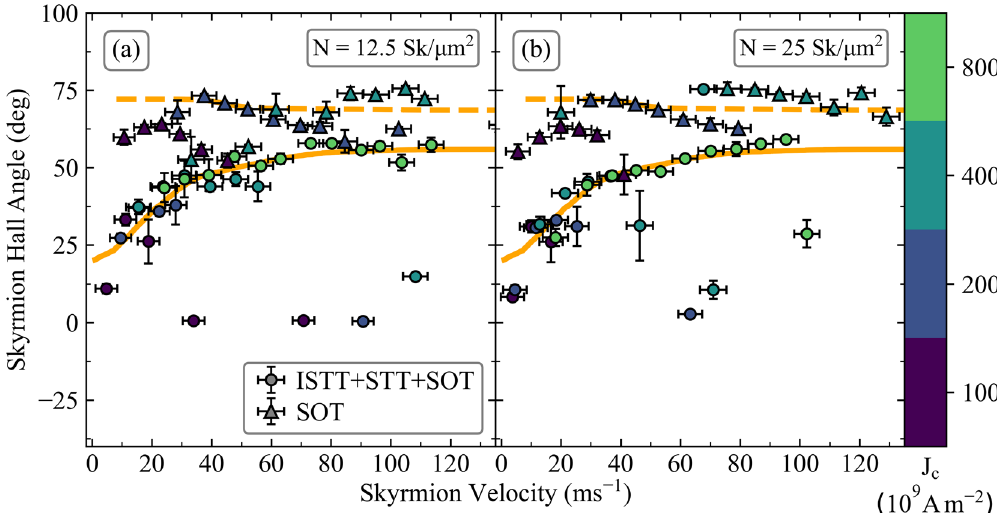
Figure 4. SkHA dependence on the skyrmion velocity with landscape disorder, for skyrmion collections with ( a ) N = 12.5 Sk/µm 2 and ( b ) N = 25 Sk/µm 2 . The solid disks and triangles show results for ISTT + STT + SOT, and SOT-only respectively, for a corresponding applied current density indicated by the colour bar. The magenta diamonds indicate the mean value obtained from experiments (average J C = 2 × 10 11 A/m 2 ). The solid and dashed lines are Savitzky–Golay-fit trend lines, for ISTT + STT + SOT, and SOT respectively, acting as a guide to the